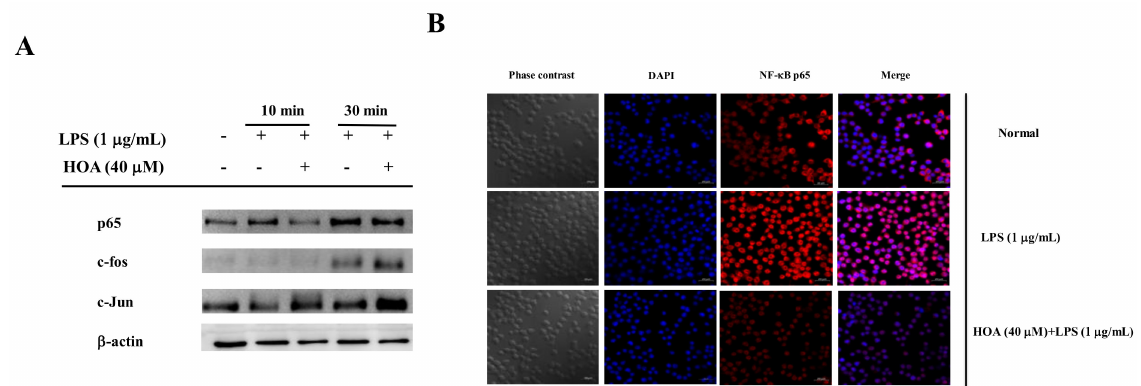
Figure 5. Effect of HOA on translocation of transcription factors in LPS-induced RAW264.7 cells. ( A ) Cells were plated at a density of 5 × 10 6 cells/dish in 60-mm culture dishes and treated with LPS and HOA for indicated time points. After preparation of the nuclear fraction, the protein expression levels of p65, c-Jun, and c-Fos were measured. ( B ) The localization of NF- κ B p65 in the cytoplasm and nuclear were visualized by a confocal